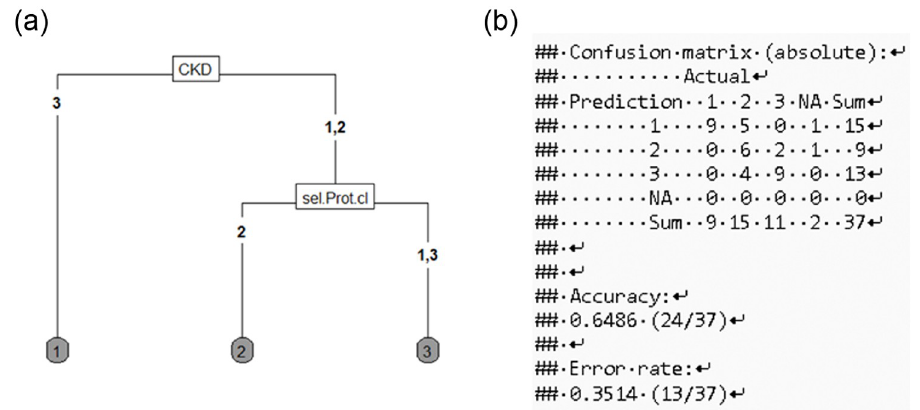
Fig 6. a, b: Outcome and its correlation with proteinuria. CKD 1: Restitution to initial function, CKD 2: Remaining new onset or worsening of existing chronic kidney disease, CKD 3: Remaining KRT. Sel. Prot.cl 1: None, 2: 30 mg/ gCrea– 300 mg/gCrea, 3: > 300 mg/gCrea, Outcome 1: Death, 2: Remaining illness, 3: Recovery. b, Confusion matrix with distribution of the predicted values in absolute numbers. Relative (not shown) describes the percentage deviation.